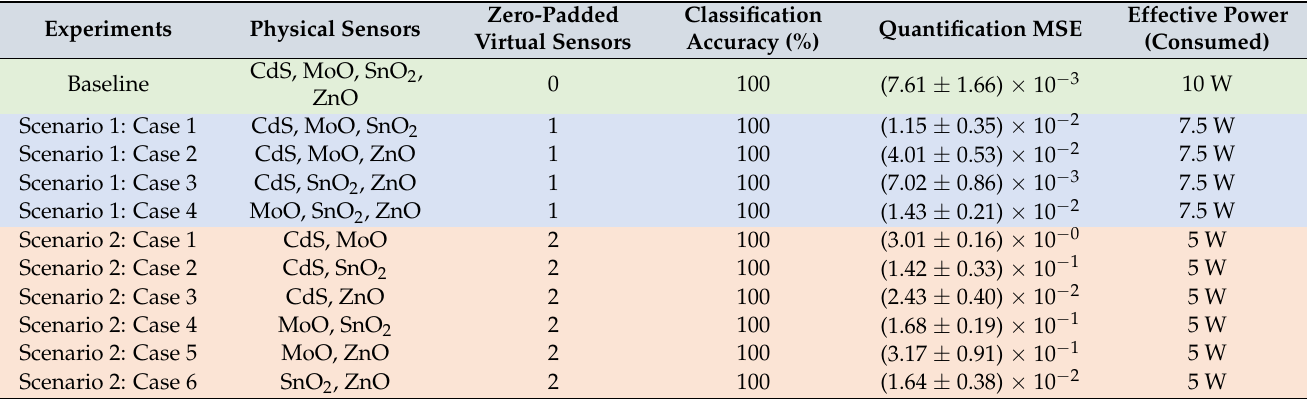
Table 1. The obtained performance metrics in baseline, scenario 1, and scenario 2